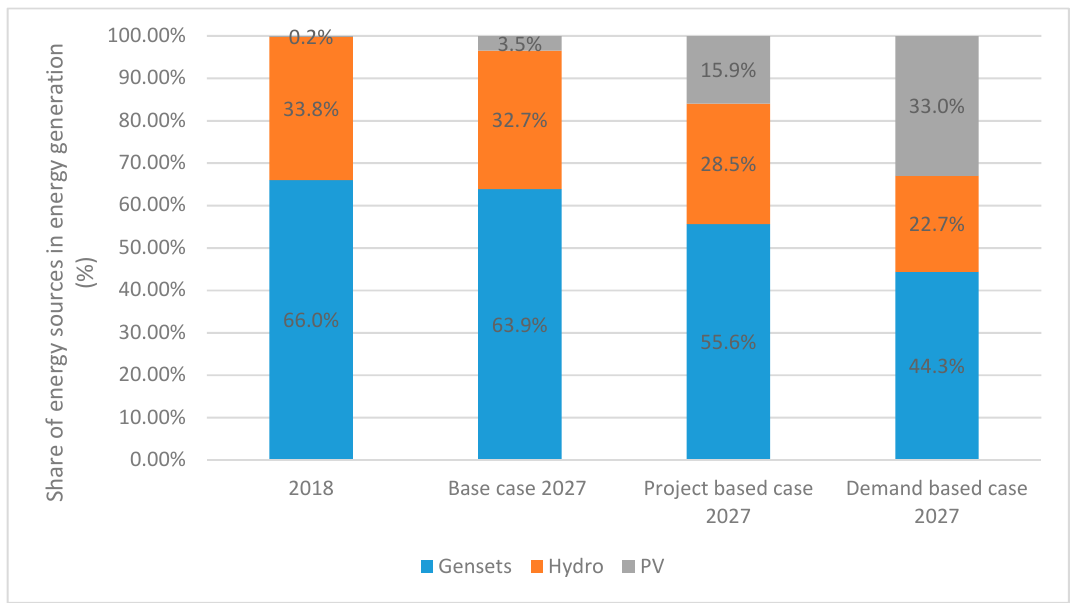
Figure 11. Share of the different energy sources in electricity generation 2018 and 2027.